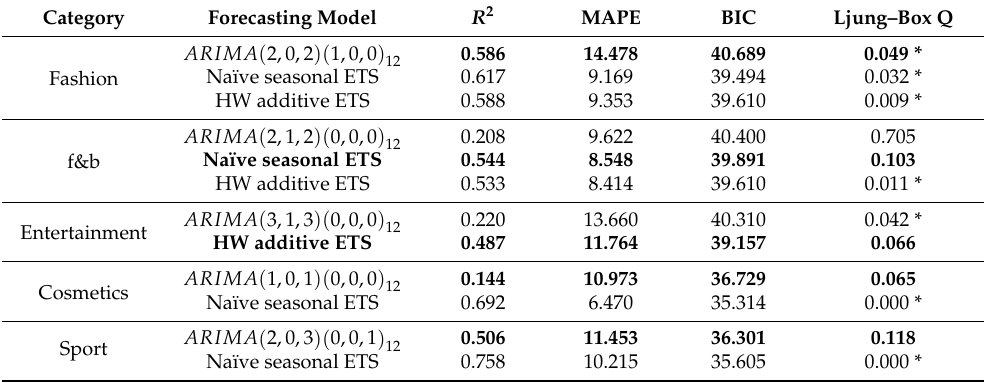
Figure 3. Actual sales (gray) and predicted sales (orange—naïve ETS, green—HW ETS, blue— ARIMA) in each retail category. ( a ) Fashion; ( b ) f&b; ( c ) entertainment; ( d ) cosmetics; ( e ) sport. Table 5. Evaluation of each retail sales forecasting model.